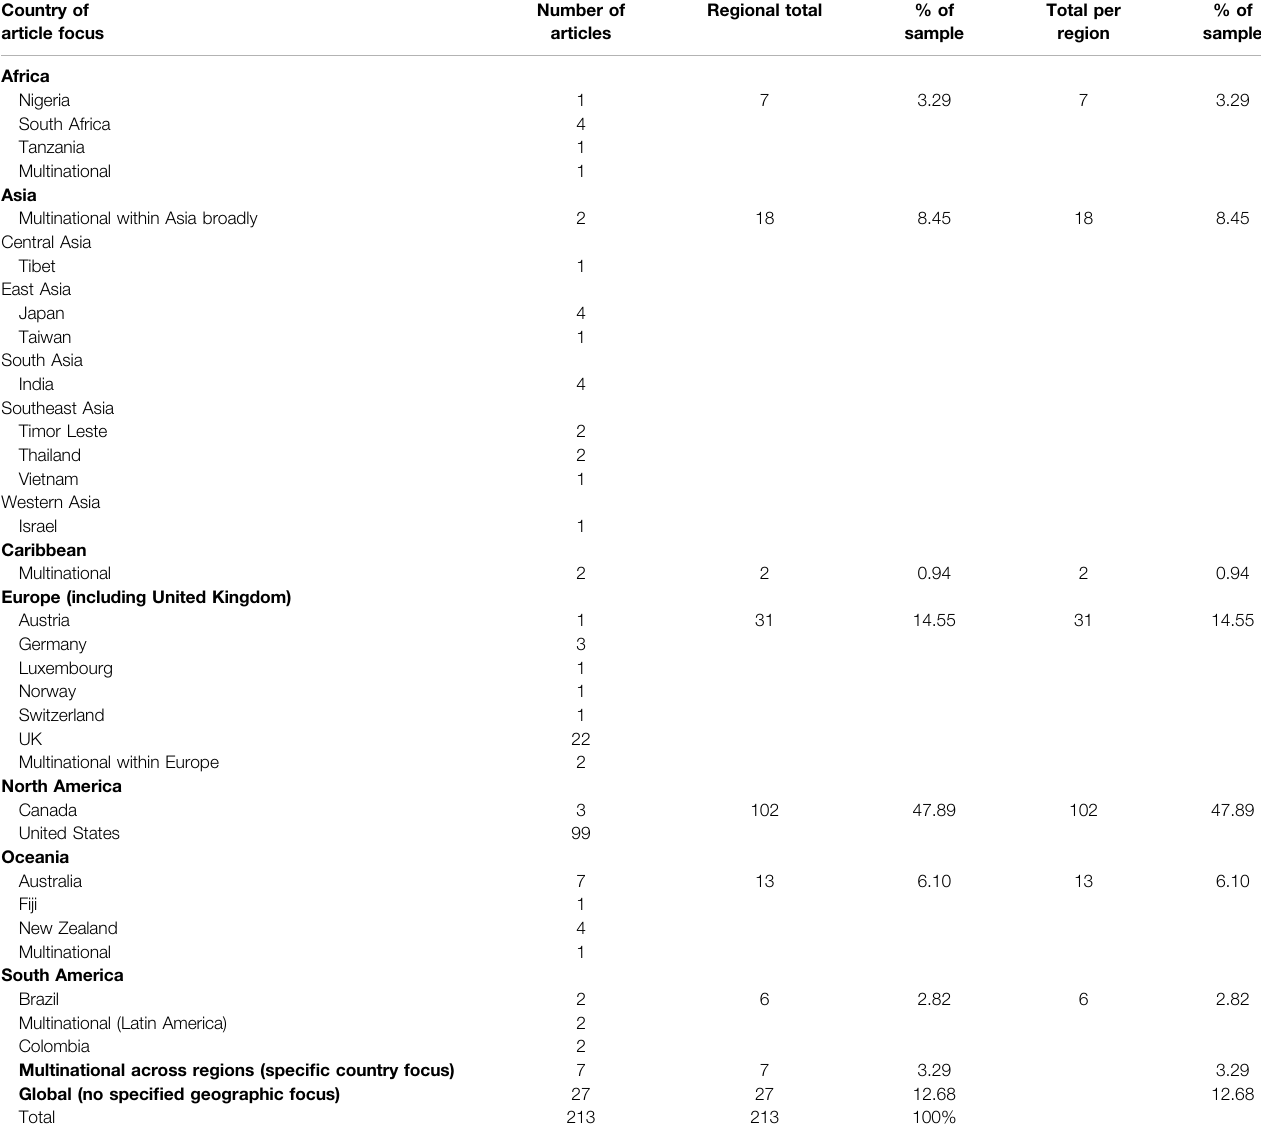
TABLE 1 | Comparison of country of focus for included